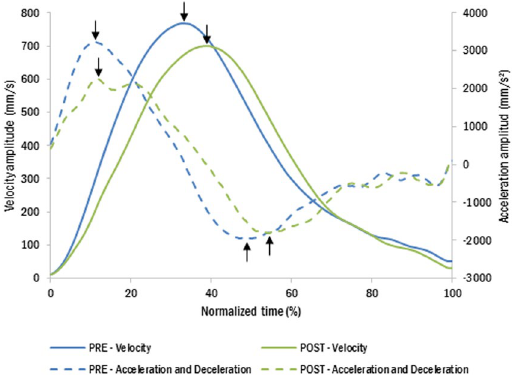
Figure 3. Kinematic profile of a representative subject (experiment 1; group 1) before (blue) and after tool use (green). After tool-use, the peaks were shorter and delayed. Black arrows indicate the positions of the extracted parameters, in amplitudes and